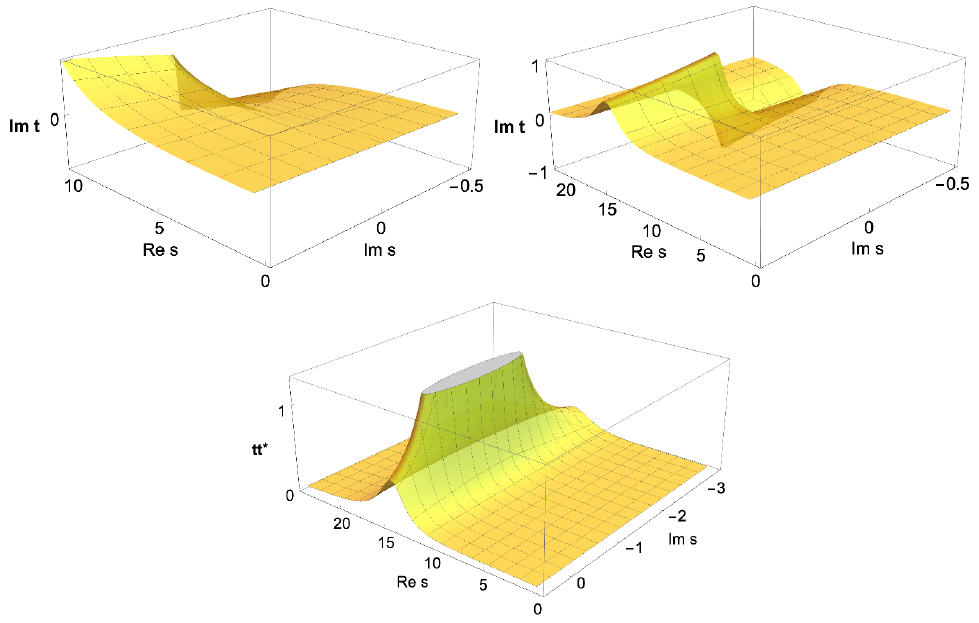
Figure 11: The resonance of figure 7 using the IAM extended to the complex s plane, = − 2.5 · 10 − 4 and a = − 1.75 · 10 − 4 . The two top with the parameters a = 0.95, a 4 5 plots show the first Riemann sheet, cut along the real axis Im ( s ) = 0. The left one is limited to low and moderate s , and only the cut is visible; the right one extends to the resonance energy that, although it does not leave a pole in this first sheet, it is seen to saturate unitarity (Im ( t ) (cid:39) 1 for a certain real s (the scale does not allow to visualize the cut). The plot in the bottom line is the extension to the second Riemann sheet and clearly features a pole for negative Im ( s ) <